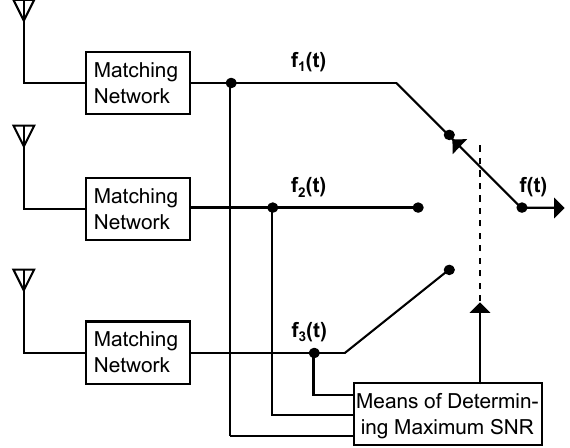
Figure 2. Schematic of a selection diversity system where the receiver is always connected to the antenna with the highest RSSI